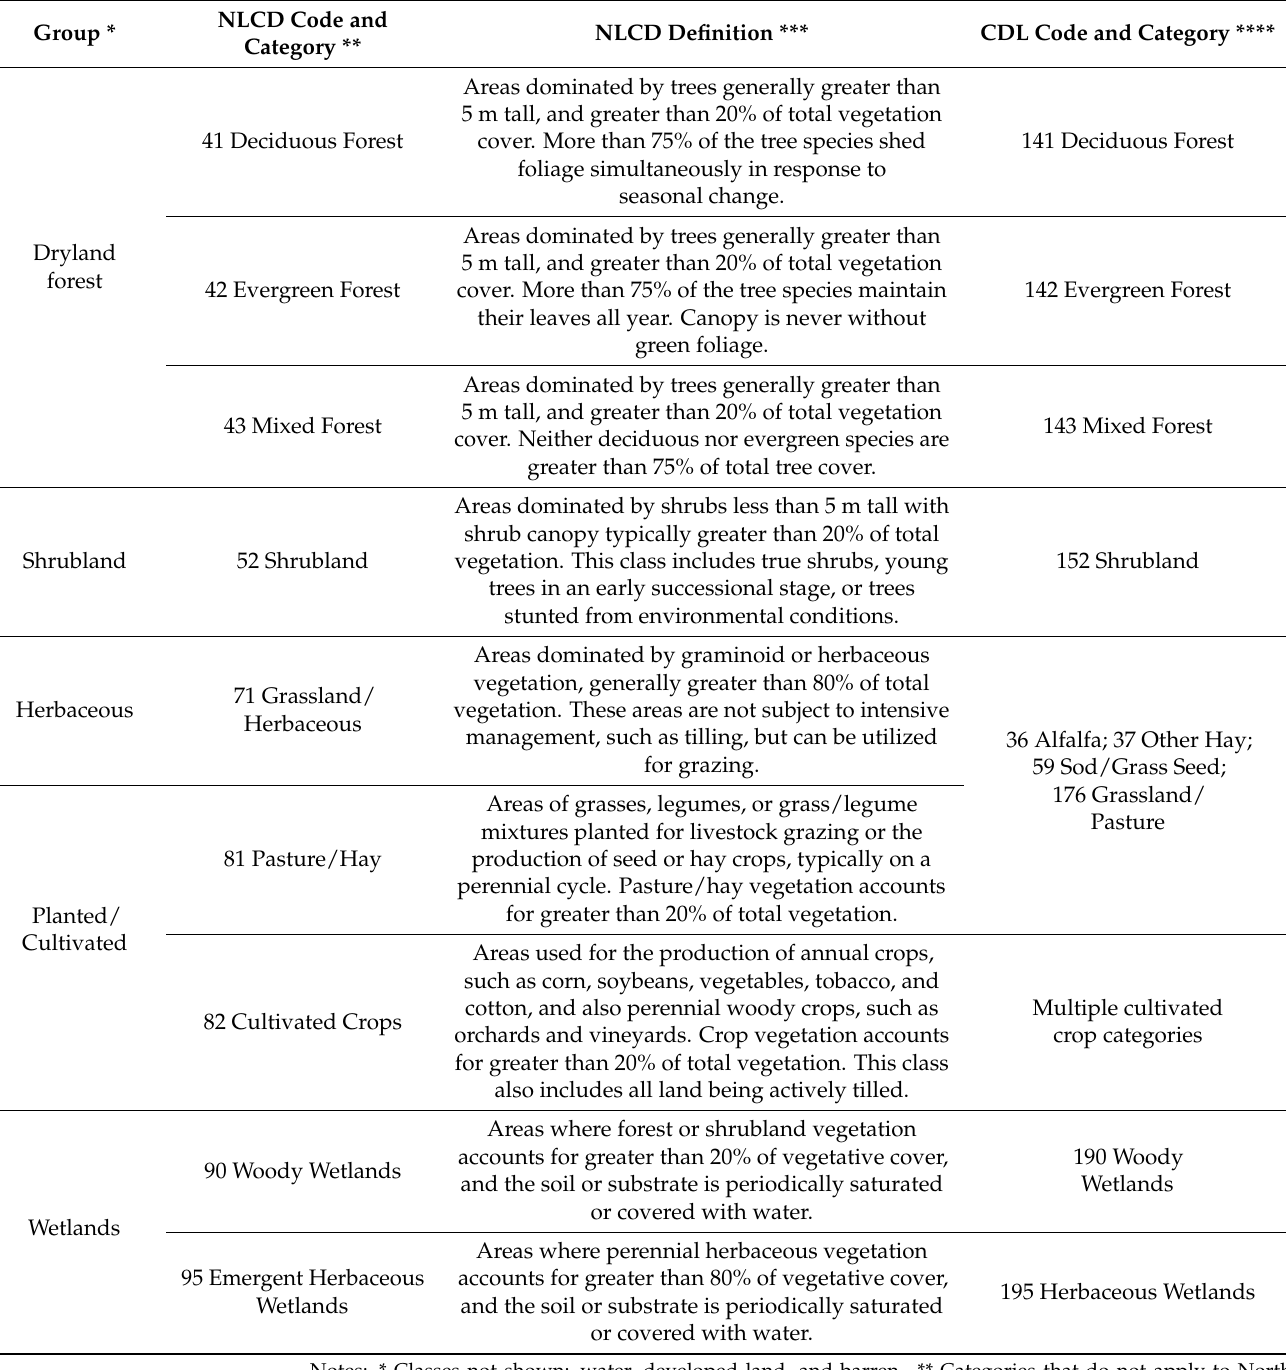
Table 1. Selected land-cover categories in CDL and